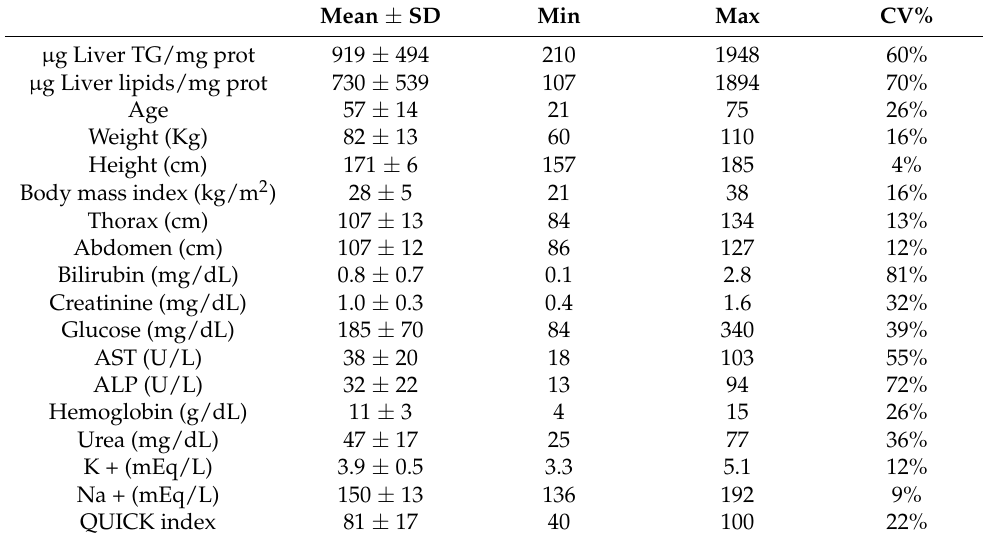
Table 3. Baseline characteristics of the donor study cohort